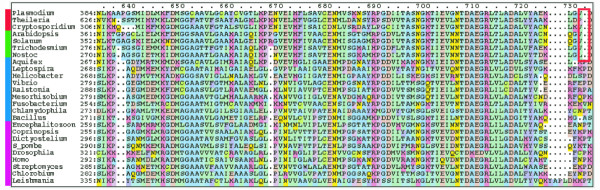
Region of leucine aminopeptidase multiple sequence alignment that illustrates several characters uniting apicomplexan sequences with plant and cyanobacterial sequences. The red box denotes an indel shared between apicomplexans, plants and cyanobacteria. The number preceeding each sequence is the position in the individual sequence at which this stretch of similarity begins. GenBank GI numbers for each sequence are as indicated in Additional data file 1. Colored boxes preceeding the alignment indicate the taxonomic group for the organisms named to the left. Red, apicomplexan; green, plant and cyanobacterial; blue, eubacterial; lavender, other protists and eukaryotes.